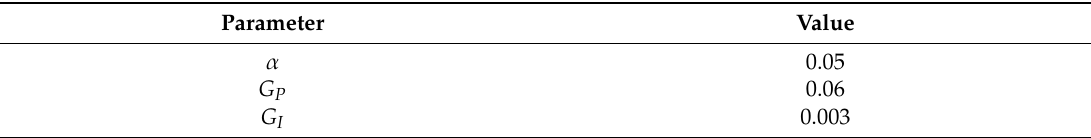
Table 2. Controller parameters of ILC.